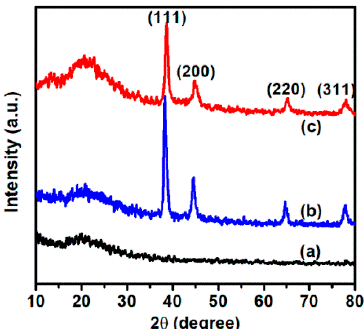
Figure 3. X-ray diffraction (XRD) patterns of RGO ( a ); AuNPs/RGO ( b ); and Ag-AuNPs/RGO ( c ). Nanomaterials 2018 , 8 , x FOR PEER REVIEW